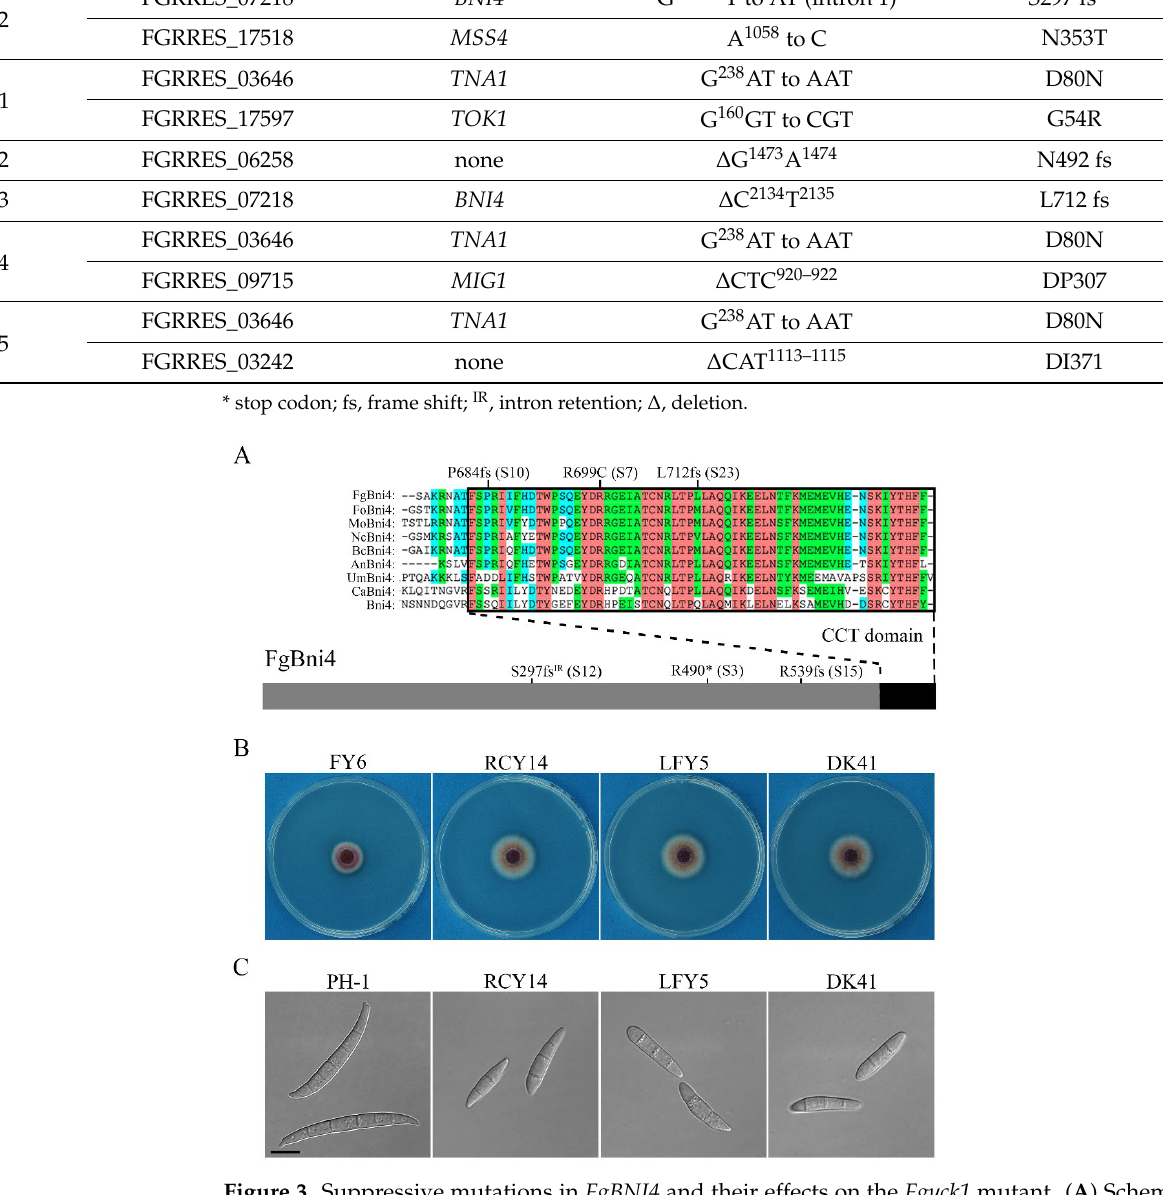
Figure 3. Suppressive mutations in FgBNI4 and their effects on the Fgyck1 mutant. ( A ) Schematic drawing of FgBni4 and positions of suppressor mutations. Sequence alignments of the conserved C-terminal region (black box) of FgBni4 with its orthologs from Fusarium oxysporum (Fo), Magnaporthe oryzae (Mo), Neurospora crassa (Nc), Botrytis cinerea (Bc), Aspergillus nidulans (An), Ustilago maydis (Um), Candida albicans (Ca), and Saccharomyces cerevisiae (Sc). The star ( ∗ ) indicates stop codon mutation. ( B ) Three-day-old PDA cultures of Fgyck1 (FY6), Fgyck1 FgBNI4 R699C (RCY14), Fgyck1 FgBNI4 Δ CT (LFY5), and Fgyck1 Fgbni4 (DK41) mutants. ( C ) Conidia of indicated strains harvested from 5-day-old CMC cultures. Bar, 10 μm.